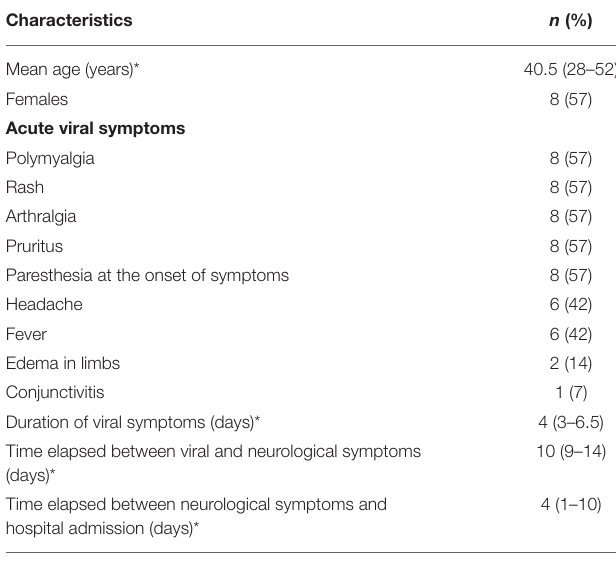
TABLE 1 | Demographic and clinical characteristics of 14 patients with GBS or subtypes in Salvador, Brazil.